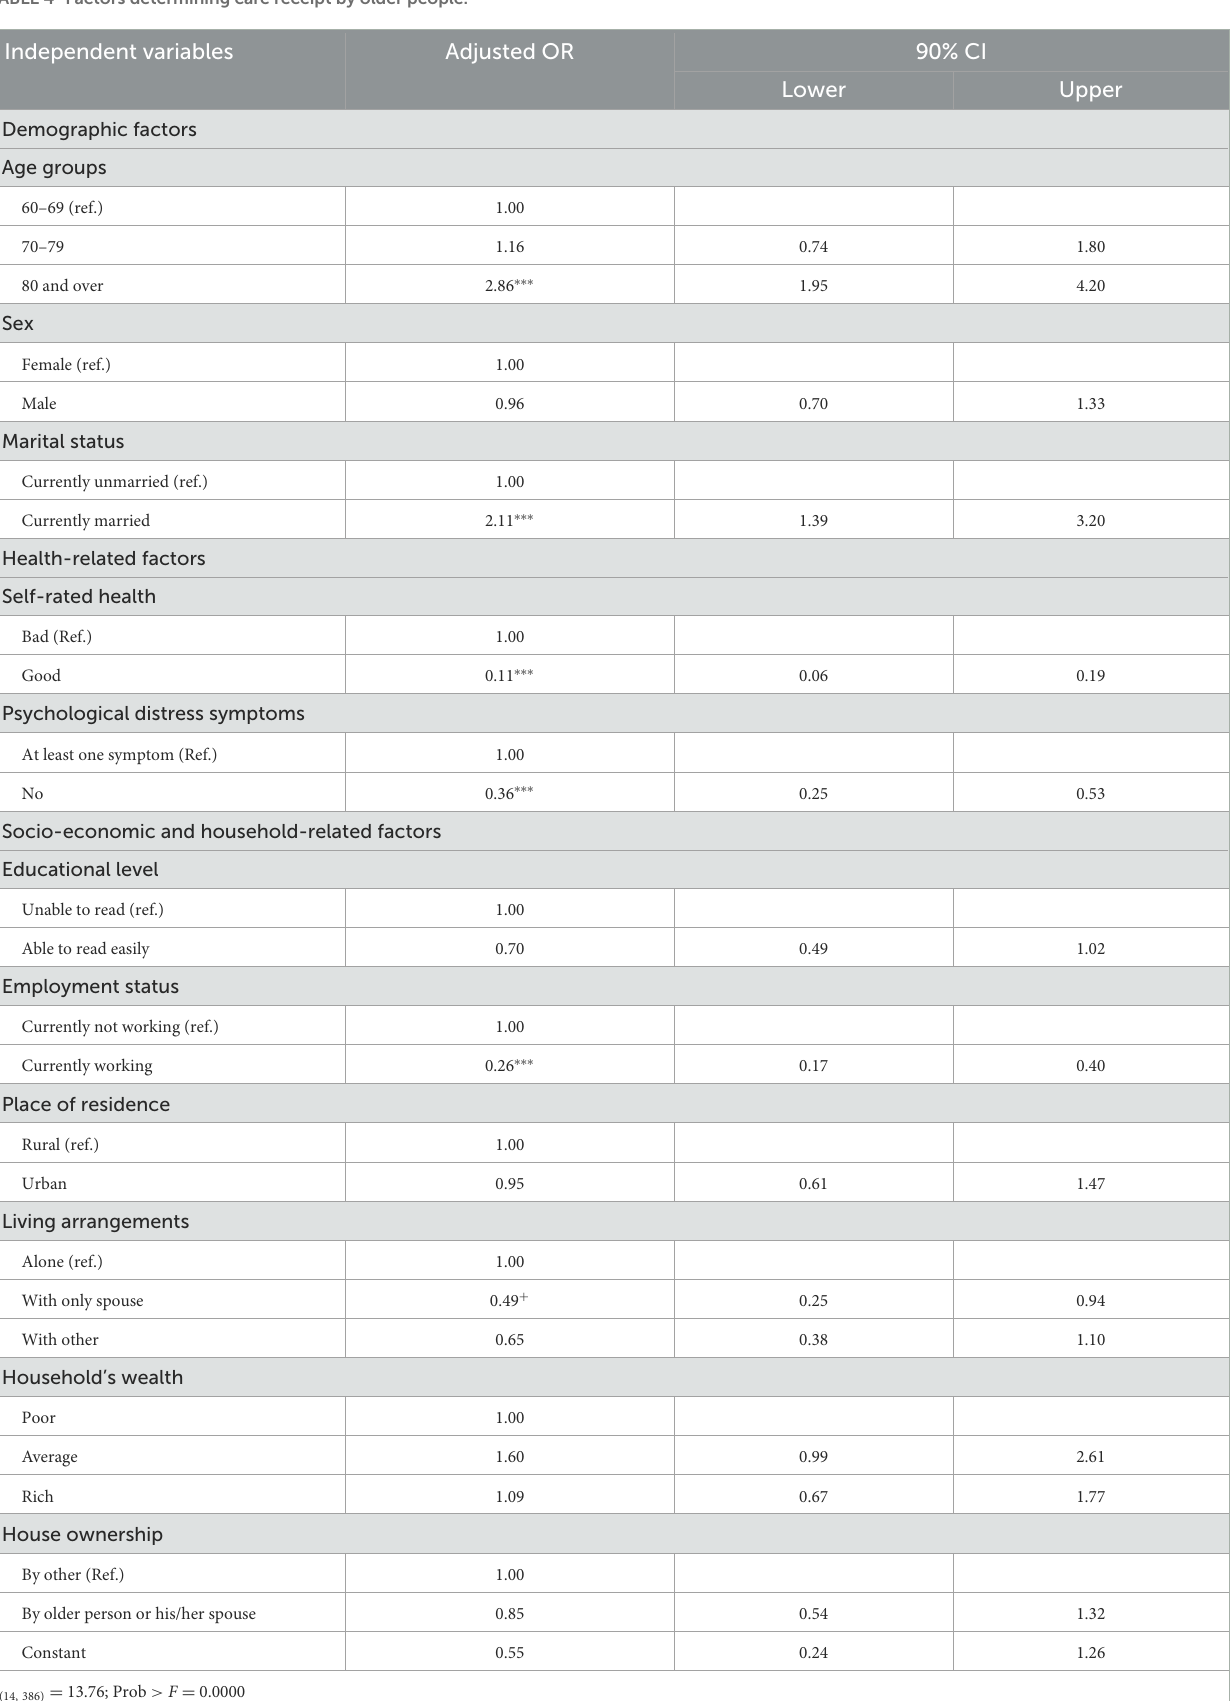
TABLE 4 Factors determining care receipt by older